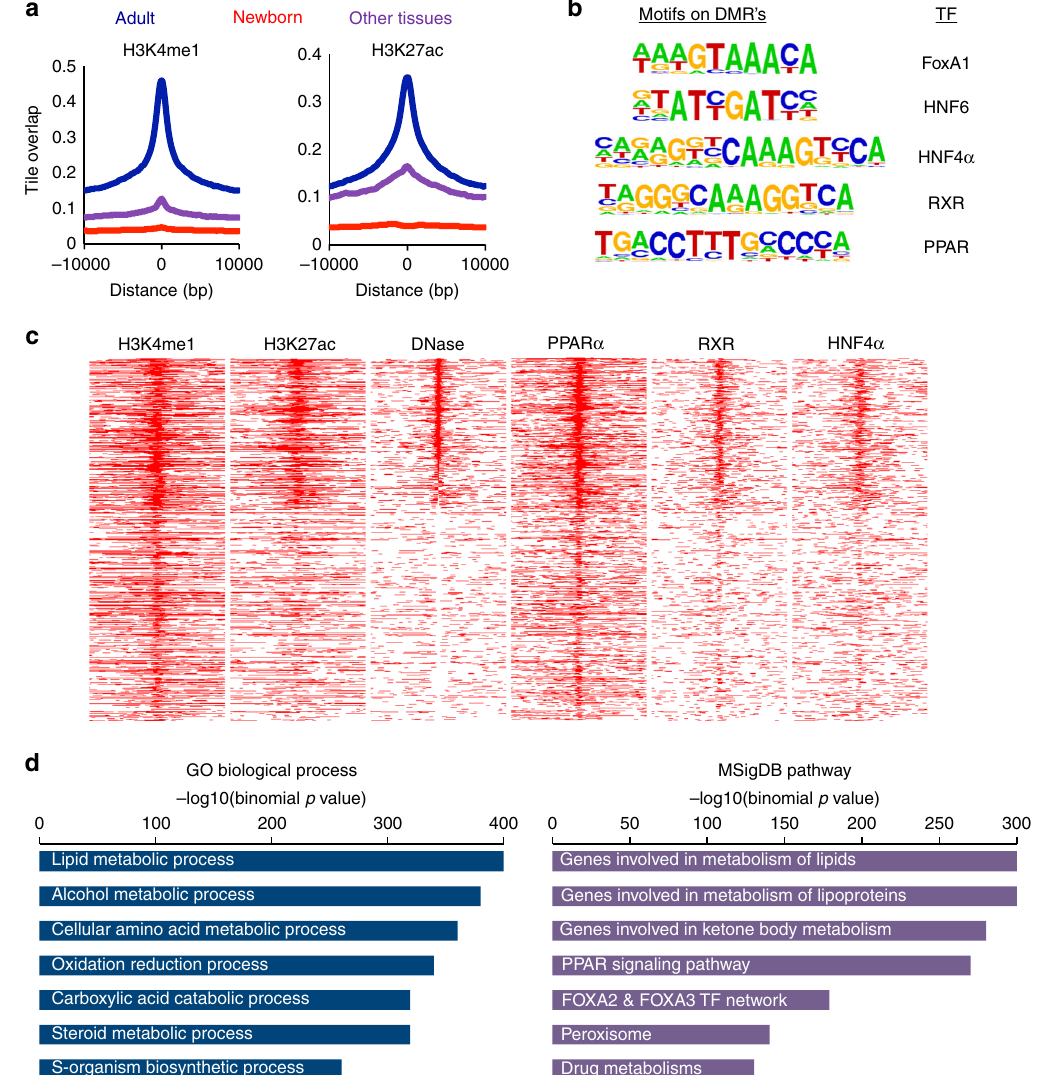
Fig. 2 Characterization of regions that undergo postnatal demethylation in hepatocytes. a ChIP-Seq of demethylated regions (52,000 200 bp tiles as determined by WGBS) as a function of distance from their center for H3K4me1 and H3K27ac in adult liver (blue), newborn liver (red), and other tissues (purple). b Transcription factor motif analysis of these same demethylated regions ( p value <10 − 300 for all motifs). c Heatmaps of H3K4me1 and H3K27ac, DNaseI, PPAR α , and HNF4 α ChIP binding in hepatocytes as a function of distance from the DMR center (±10 kb) ranked according to the DNaseI lane. d Gene ontology and pathways associated with postnatal demethylated